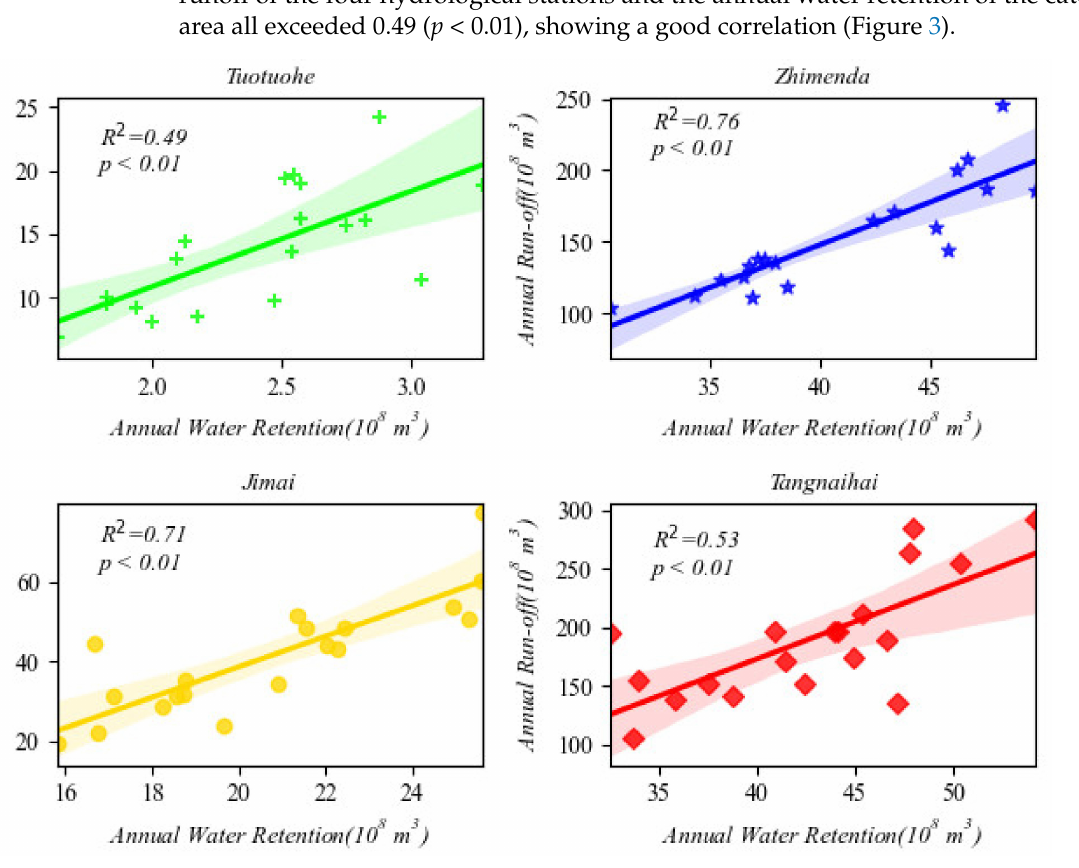
Figure 3. Verification of water retention and